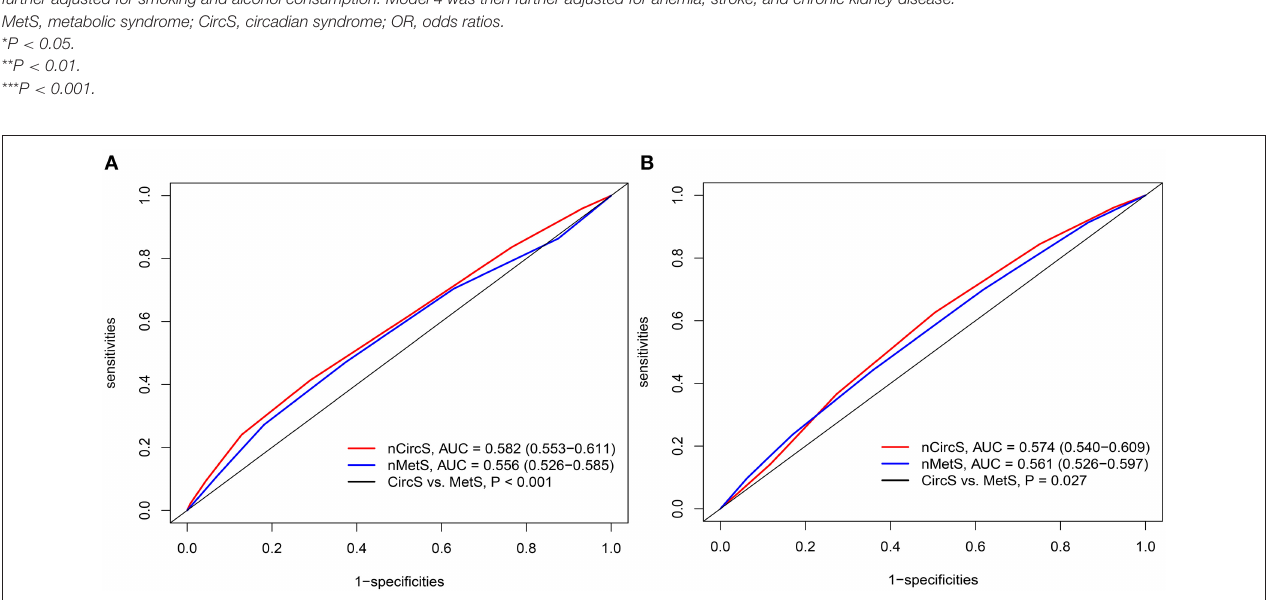
FIGURE 4 | The receiver operating characteristic curve (ROC) curves for prevalent and incident LUTS/BPH. (A) ROCs for the prevalent LUTS/BPH in 2011. (B) ROCs for the incident LUTS/BPH (2011–2015). PROC package in R 3.6.3 was adopted to perform ROC analyses. DeLong test was employed to compare the AUCs for CircS and MetS. The number of CircS and MetS components were set as independent variables. nMetS, number of metabolic syndrome components; nCircS, number of circadian syndrome components; ROC, receiver operating characteristic curve; AUC, area under